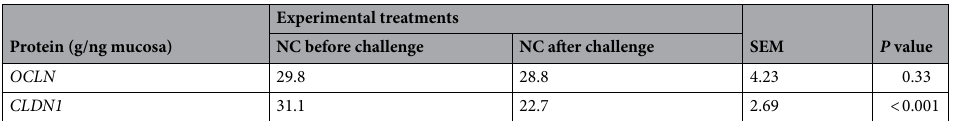
Table 1. Effect of Eimeria challenge on ileal OCLN and CLDN1 protein expression (SEM: standard error of mean).